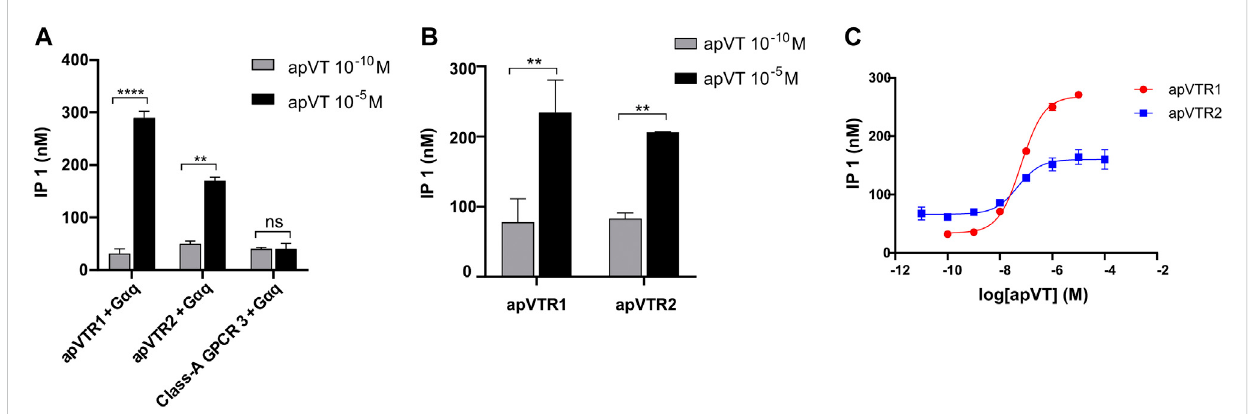
Activation of putative receptors by apVT determined using IP1 accumulation assay. (A) Screening of potential activation of apVT on three putative receptors using two apVT concentrations with co-transfection with the promiscuous G α q: 10 − 10 M and 10 − 5 M. At 10 − 10 M, a peptide activated a receptor minimally,ifatall,soitisusedasacontrol.ThedataindicatethatapVTR1andapVTR2arereceptorsforapVT,whereasClass-AGPCR3isnot. (B) Activation of apVTR1 and apVTR2 by apVT using two concentrations without co-transfection with the promiscuous G α q: 10 − 10 M and 10 − 5 M. Paired t -test, ns, not signi fi cant; **, p < 0.01; ****, p < 0.0001; error bar: SEM. (C) Representative examples of dose-response curves of the activation of apVTR1 and apVTR2 by the Aplysia